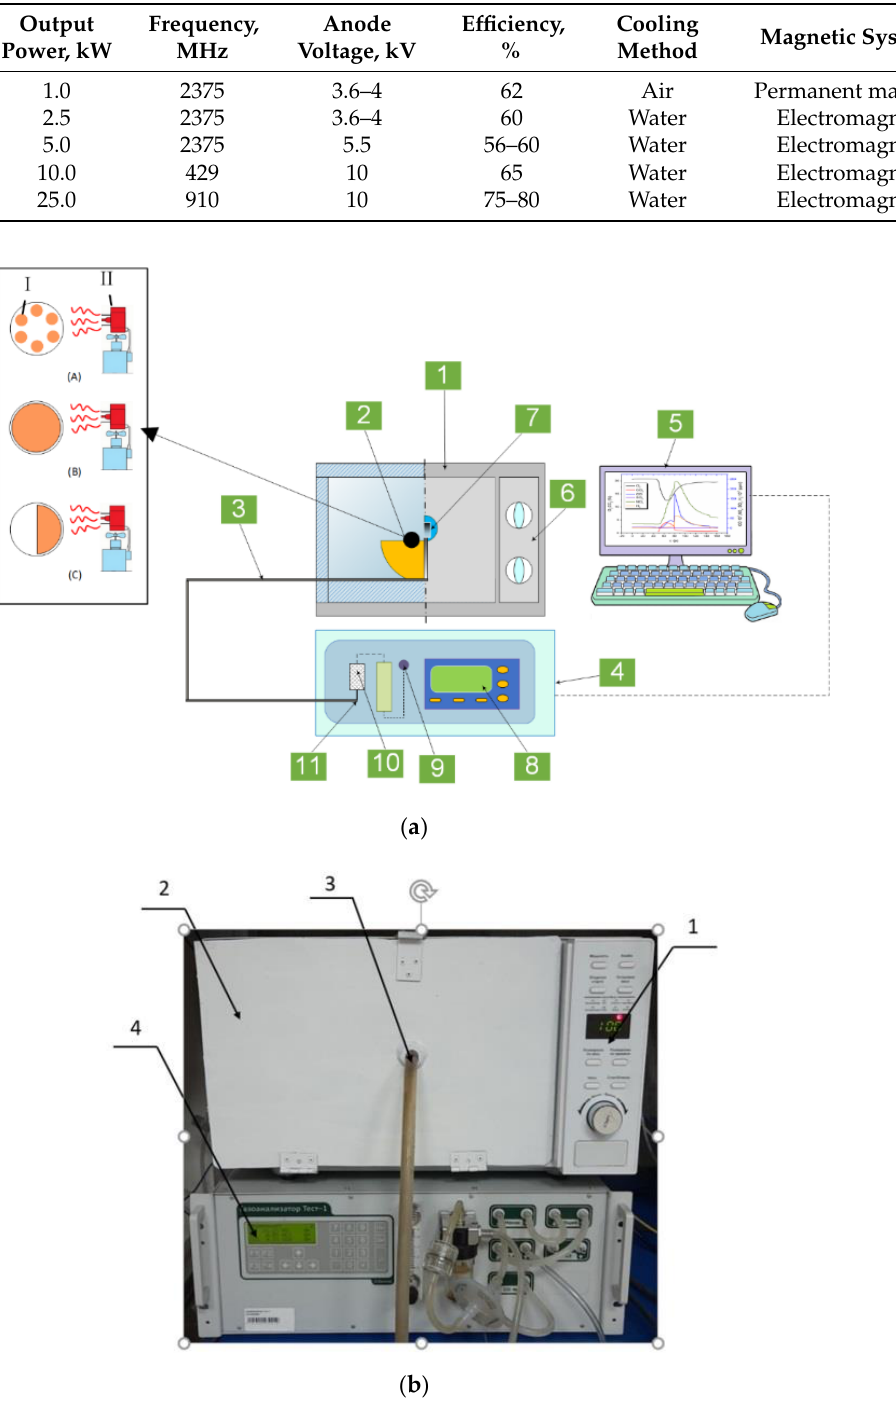
Figure 1. ( a ). Experimental setup scheme: 1—microwave oven; 2—sampling crucible with biomass; 3—gas sampling hose; 4—gas analyzer; 5—PC; 6—furnace control unit; 7—modular probe; 8—measurement display; 9—gas inlet; 10—filter; 11—moisture collector; I—biomass sam- ple; II—magnetron; A—distribution of a sample along the edges of the crucible; B—distribution of a sample on the entire bottom of the crucible; C—distribution of a sample on a half of the cru- cible bottom, ( b ). Experimental setup: 1—control unit; 2—microwave oven; 3—gas sampling